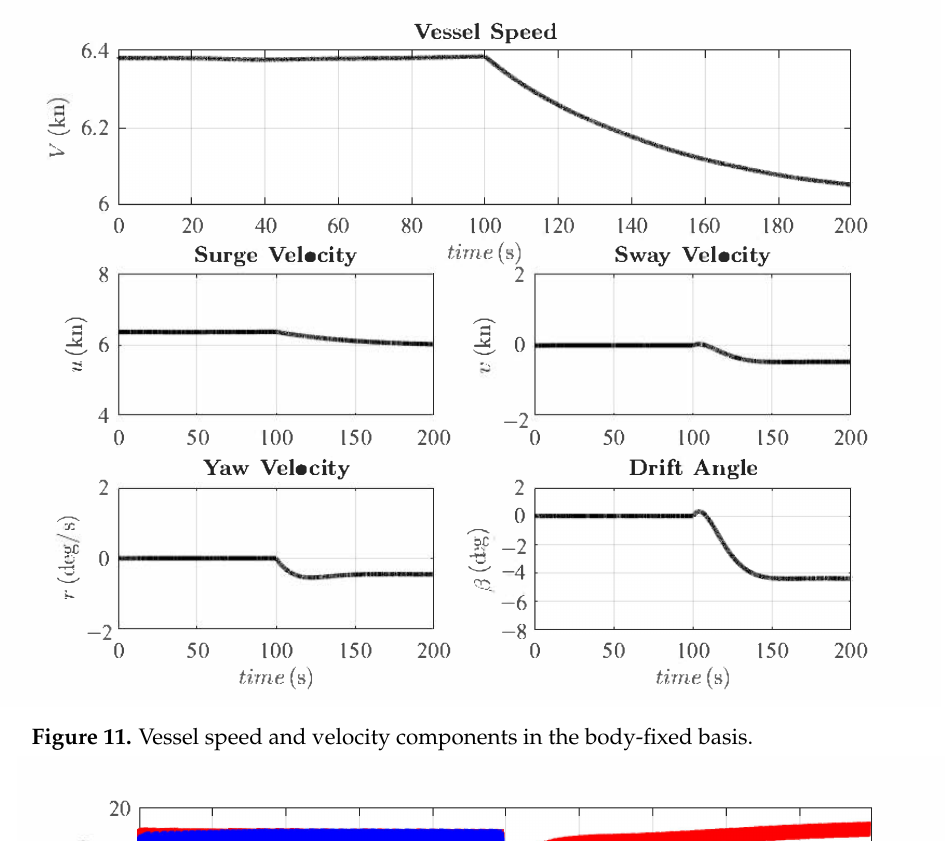
Figure 11. Vessel speed and velocity components in the body-fixed basis.